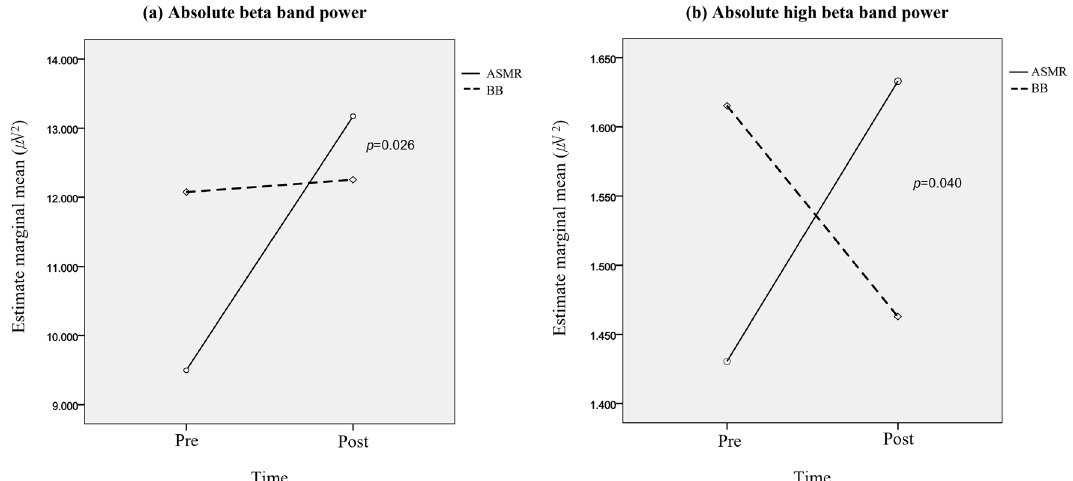
Figure 2. Differences in the changes of absolute power between the ASMR and BB interventions. Group-by- time interaction in absolute beta band power ( a ) and absolute high beta band power ( b ). ASMR : Autonomous sensory meridian response, BB : Binaural beat.